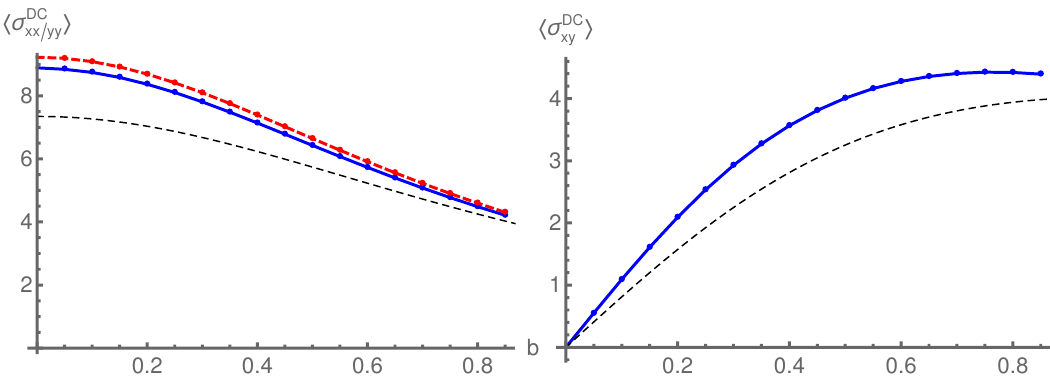
Figure 7 . The averaged DC conductivities as functions of the magnetic field for µ = 4 : (Left) h σ xx i is dashed red and h σ yy i is solid blue; (Right) h σ xy i and −h σ yx i , whose values are equal to precision of our numerics, are both shown by solid blue. The curves show the DC conductivities obtained from the analytic results of appendix A, and the dots are the numerical results for optical conductivities extrapolated to ω = 0 . For both plots, the black dashed curve shows the DC conductivity of the homogenous phase (also at µ = 4 ) for